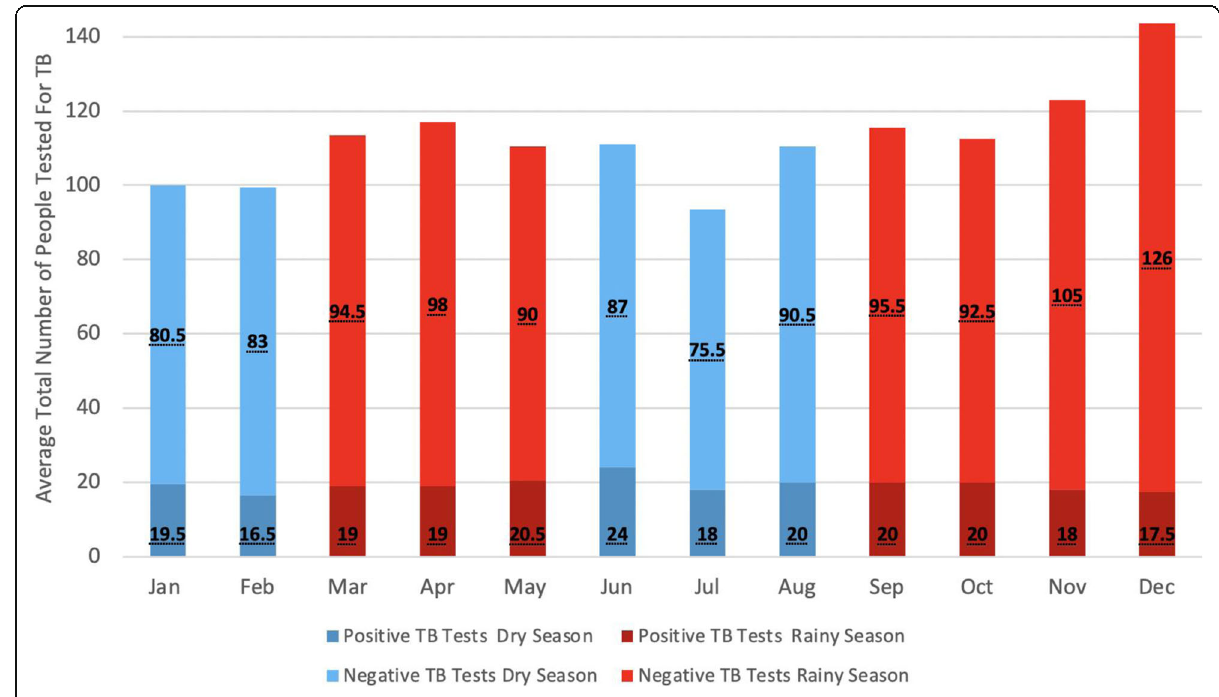
Fig. 2 Average number of positive and negative TB tests per month (2016 –